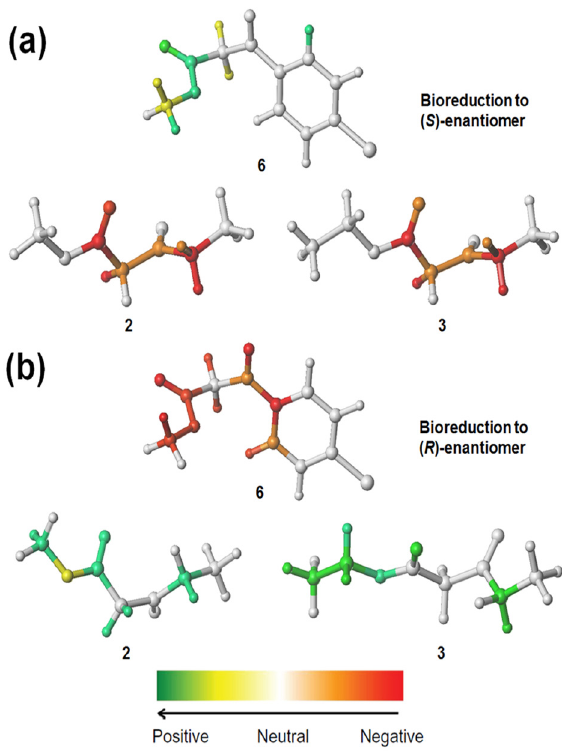
Figure 2 - Hologram quantitative structure-activity relationship (HQSAR) contribution maps of the most and least bioconverted to ( S )-enantiomer ( a ) and ( R )-enantiomer ( b ) by K. marxianus